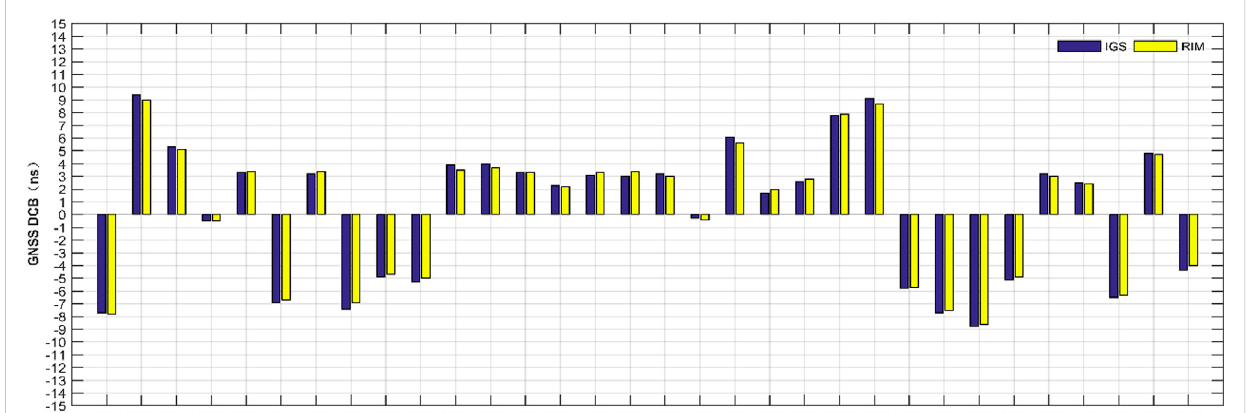
FIGURE 3 GPS satellite DCB values based on the RIM model and from IGS.